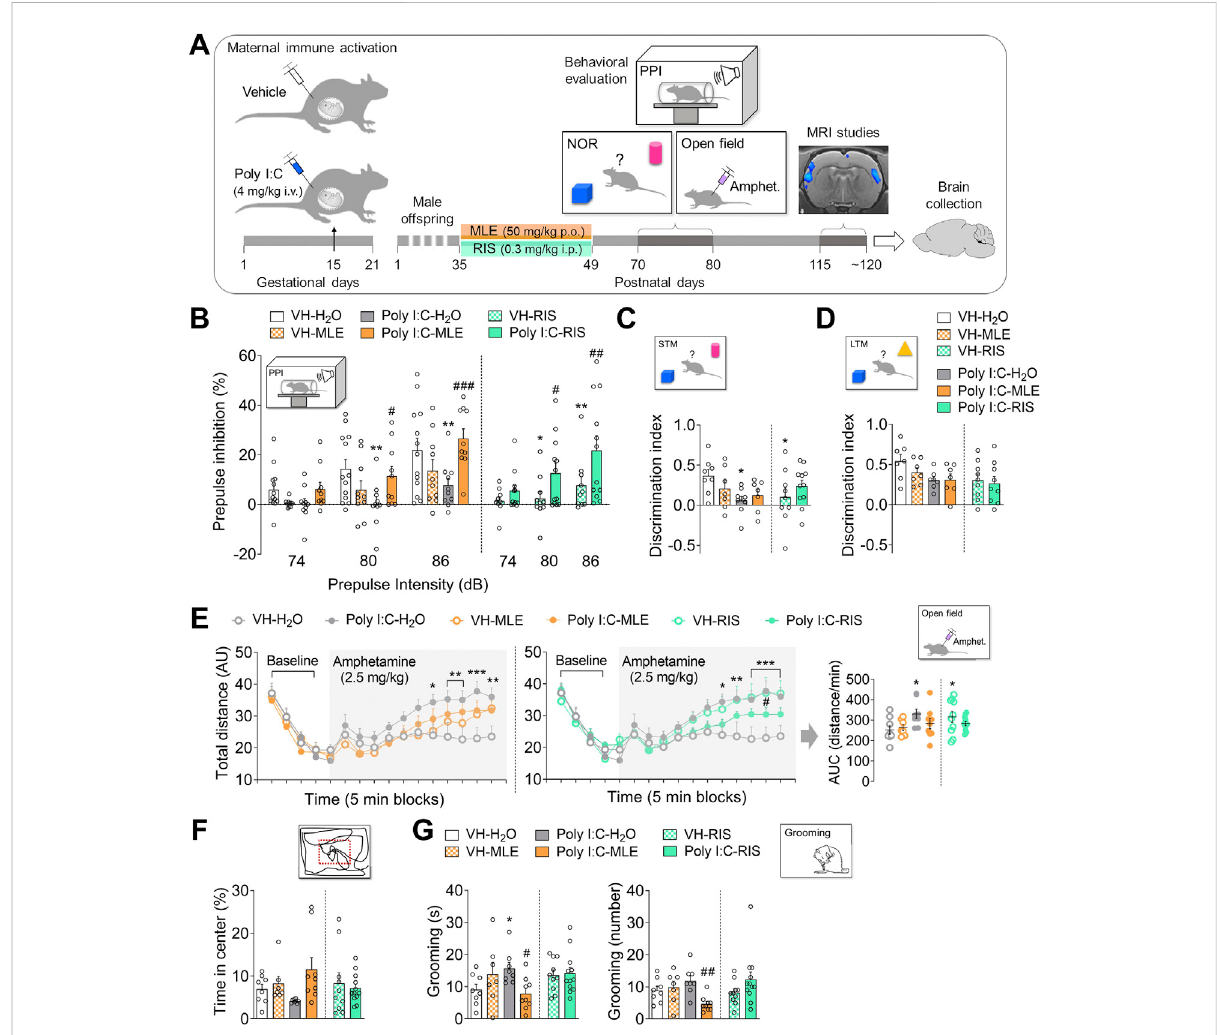
FIGURE 2 TheeffectofMLEorrisperidone(RIS)treatmentduringadolescenceonthebehaviorofthePolyI:Coffspring. (A) Experimentaltimelineshowing the design to study the effect of MLE treatment during adolescence. Maternal immune activation was induced in pregnant dams by administering Poly I:C (4 mg/kg i.v., intravenously) or the vehicle alone (controls) on gestational day (GD) 15. Male offspring were treated orally (p.o.) with MLE at a daily dose of 50 mg/kg of mangiferin during adolescence (postnatal day, PND 39-54) or administered intraperitoneally (i.p.) with risperidone (RIS, 0.3 mg/kg) as an adolescence reference treatment. Behavioral evaluation and magnetic resonance imaging (MRI) studies were performed at adulthood (PND 70-80 and PND 115-120, respectively). Finally, brain samples were collected at the end of the experiments. (B) The effect of adolescent MLE or RIS treatment on prepulse inhibition (PPI) test. The percentage PPI is represented for a 74, 80 and 86 dB prepulse intensity. (C,D) The effect of adolescent MLE or RIS treatment on the short-term (STM) and long-term memory (LTM) discrimination index between objects in the novel object recognition test (NOR). (E) The effect of adolescent MLE (left) or RIS (right) treatment on amphetamine sensitivity. The total distance travelled in the open fi eld is represented in 5 min (min) blocks, before and after amphetamine injection (shaded area, 2.5 mg/kg i.p.). In addition, the area under the curve (AUC) values of amphetamine-induced activity were represented from 5 min after amphetamine injection. (F) The effect of adolescent MLE or RIS treatment on anxiety-like behavior. The time spent (%) in the center is represented during the baseline period of free exploration in the open fi eld. (G) The effect of adolescent MLE or RIS treatment on grooming behavior. The total time spent grooming and the number of grooming events are represented during the last 10 min of the baseline period in the open fi eld. The data are represented as the mean ± SEM of 10 – 13 animals per group in PPI test, 7-11 animals per group in the STM and LTM phases of the NOR test, and 7-12 animals per group for amphetamine induced activity, anxiety-like and grooming behaviors. * p < 0.05, ** p < 0.01, *** p < 0.001 vs. VH-H 2 O; # p < 0.05, ## p < 0.01, ### p < 0.001 vs. Poly